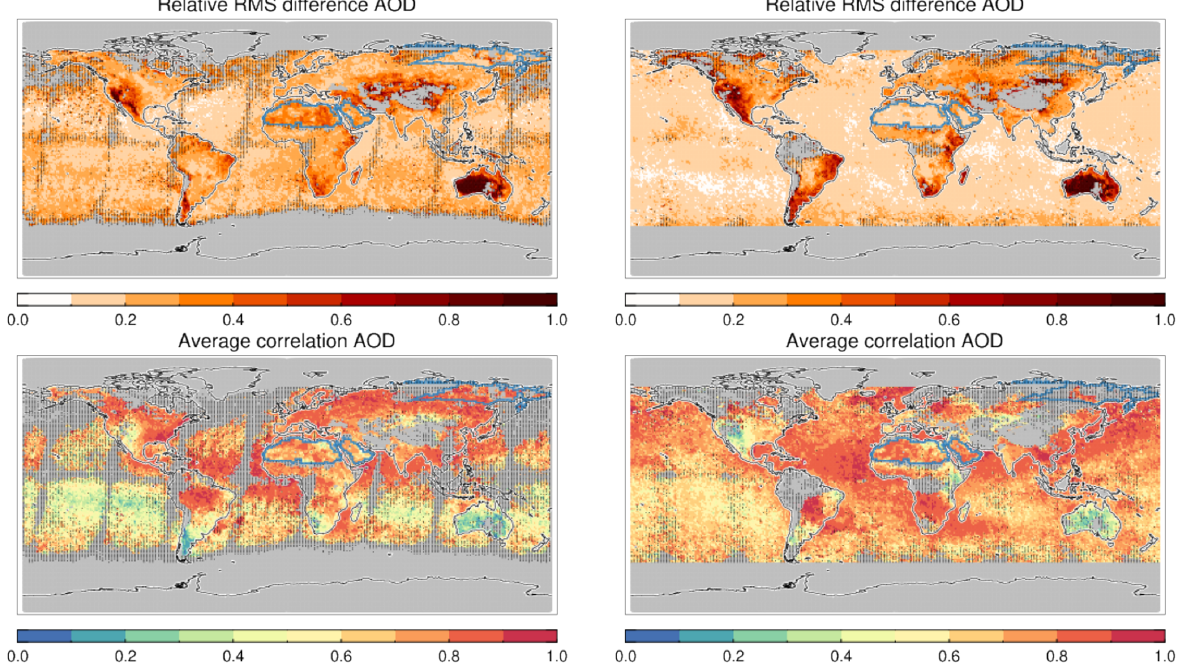
Figure 21. Global maps of relative diversity and average correlation of collocated satellite products. Diversity is the spread in AOD over the mean AOD. The average correlation is the average over all pair-wise correlations possible. Dotted areas indicate that the uncertainty due to statistical noise (standard deviation) is at least 0.1 (or fewer than 10 super-observations for each product were available). Over land, all seven products are used (blue contours identify areas of exception); over ocean at most four products are used (see text). Morning (left) and afternoon (right) products were collocated within